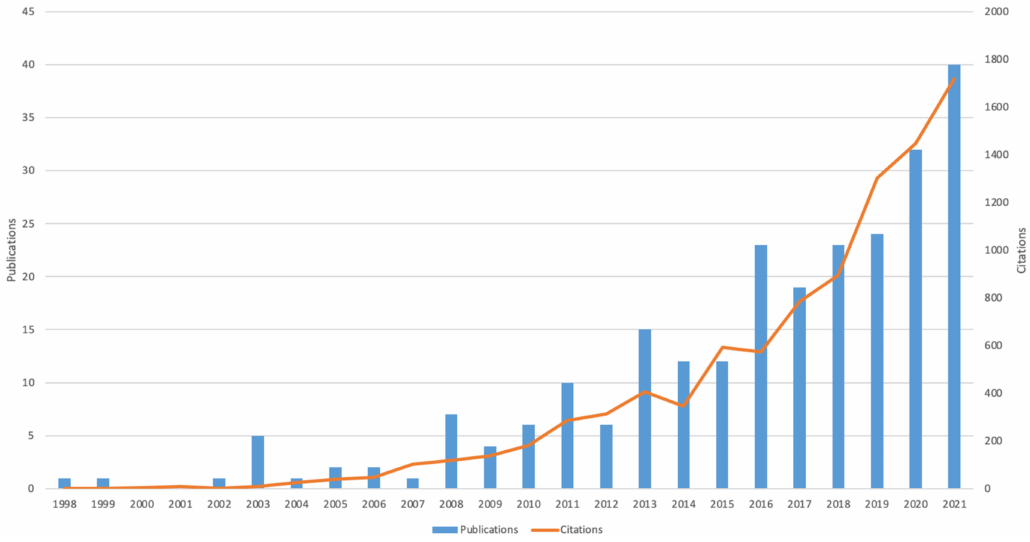
Figure 2. The number of documents and citations per year from 1998 to